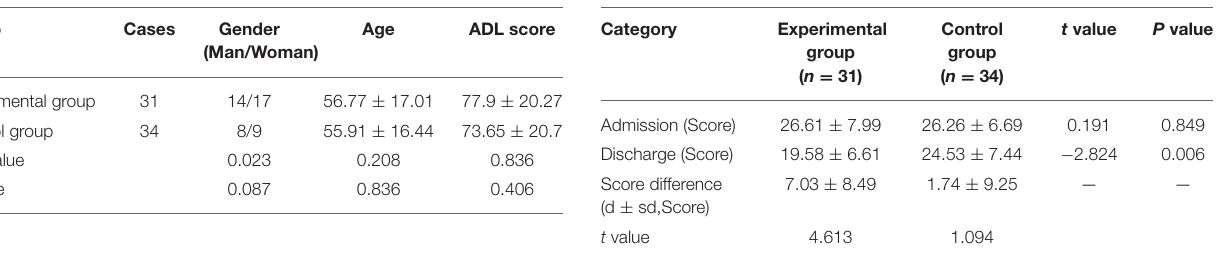
TABLE 2 | Comparison of disease coping styles between the two groups.